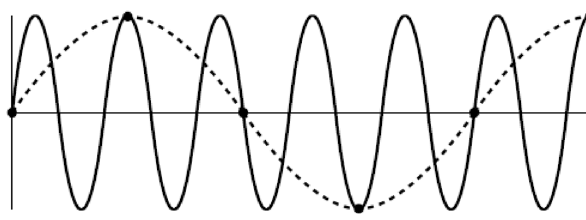
Fig. 15 Result of multi-attribute analysis (10 attributes by length operator 5) for the second category of data. The black curve repre- sents total failure, and the red curve represents validation error